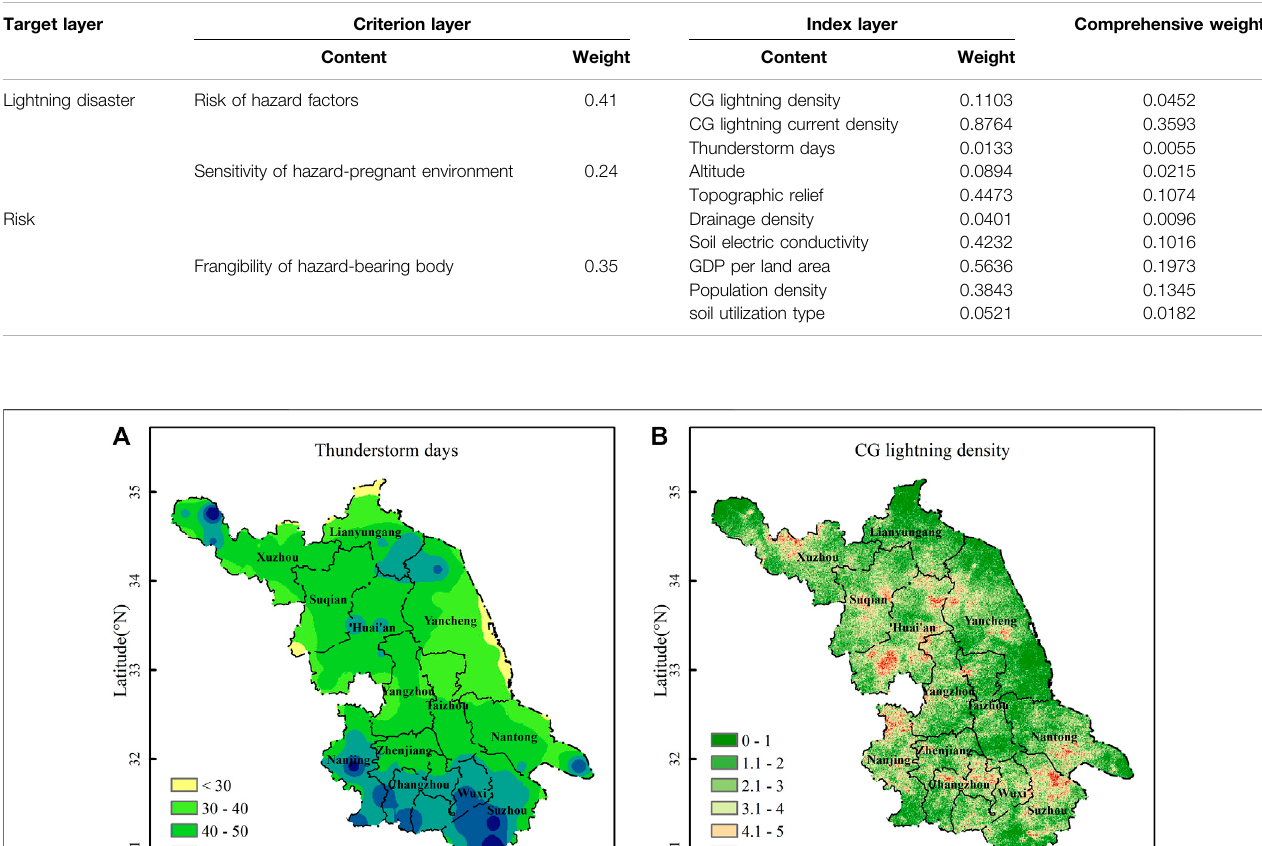
TABLE 3 | Weights of lightning disaster risk assessment indexes in Jiangsu.